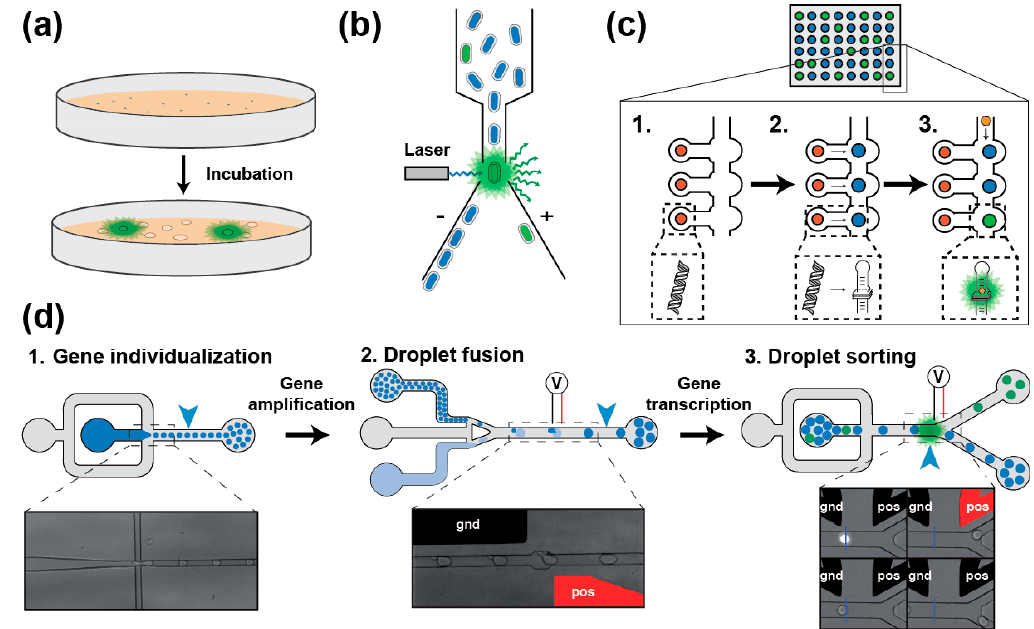
Figure 3. Main screening strategies for isolating light-up RNA aptamers. ( a ) Colony screening [31,62]. SELEX-enriched gene library is cloned and expressed in bacteria plated on a solid medium supplemented with the fluorogen. Upon incubation, colonies expressing light-up aptamers are identified by fluorescence emission (green shadow) when illuminated with fluorogen excitation wavelength. ( b ) FACS-based bacteria screening [31]. SELEX-enriched gene library is cloned and expressed in bacteria incubated in the presence of the fluorogen. Bacteria fluorescence is then analyzed on a FACS using a laser exciting the fluorogen. Fluorescence emitting bacteria (green shadow) are then deflected and sorted from the rest of the population. ( c ) Miniaturized in vitro screening using large integration scale microfluidic devices [64]. DNA coding for each variant is first spotted (red dots, Step 1) onto a surface prior to assembling the microfluidic chip. Then, each DNA cluster is transcribed in RNA later captured on a second spot of the chip (blue spot, Step 2). Finally, flowing the fluorogen into the microfluidic channels (Step 3) allows the detection of light-up aptamers (green spot). Quantifying the fluorescence emitted by each construct at various concentrations of fluorogen allows the determination of parameters such as the brightness and the dissociation constant ( K D ). ( d ) Droplet-based microfluidic in vitro screening workflow [65]. A gene library is diluted into a PCR mixture (in dark blue) prior to individualizing the molecules into picoliter-sized water-in-oil droplets carried by an oil phase (in gray, Step 1). Upon off-chip PCR amplification, small and amplified DNA-containing droplets (dark blue) are synchronized and fused with larger droplets containing an in vitro transcription mixture supplemented with the fluorogen (light blue, Step 2). Upon an incubation step allowing for in vitro transcription to take place, the fluorescence of each droplet is analyzed and those droplets containing a light-up aptamer (in green) are sorted from the rest of the population (in blue). Both fusion and sorting events are triggered by the application of an electric field to built-in positive (pos, shown in red) and ground (gnd, shown in black) electrodes.